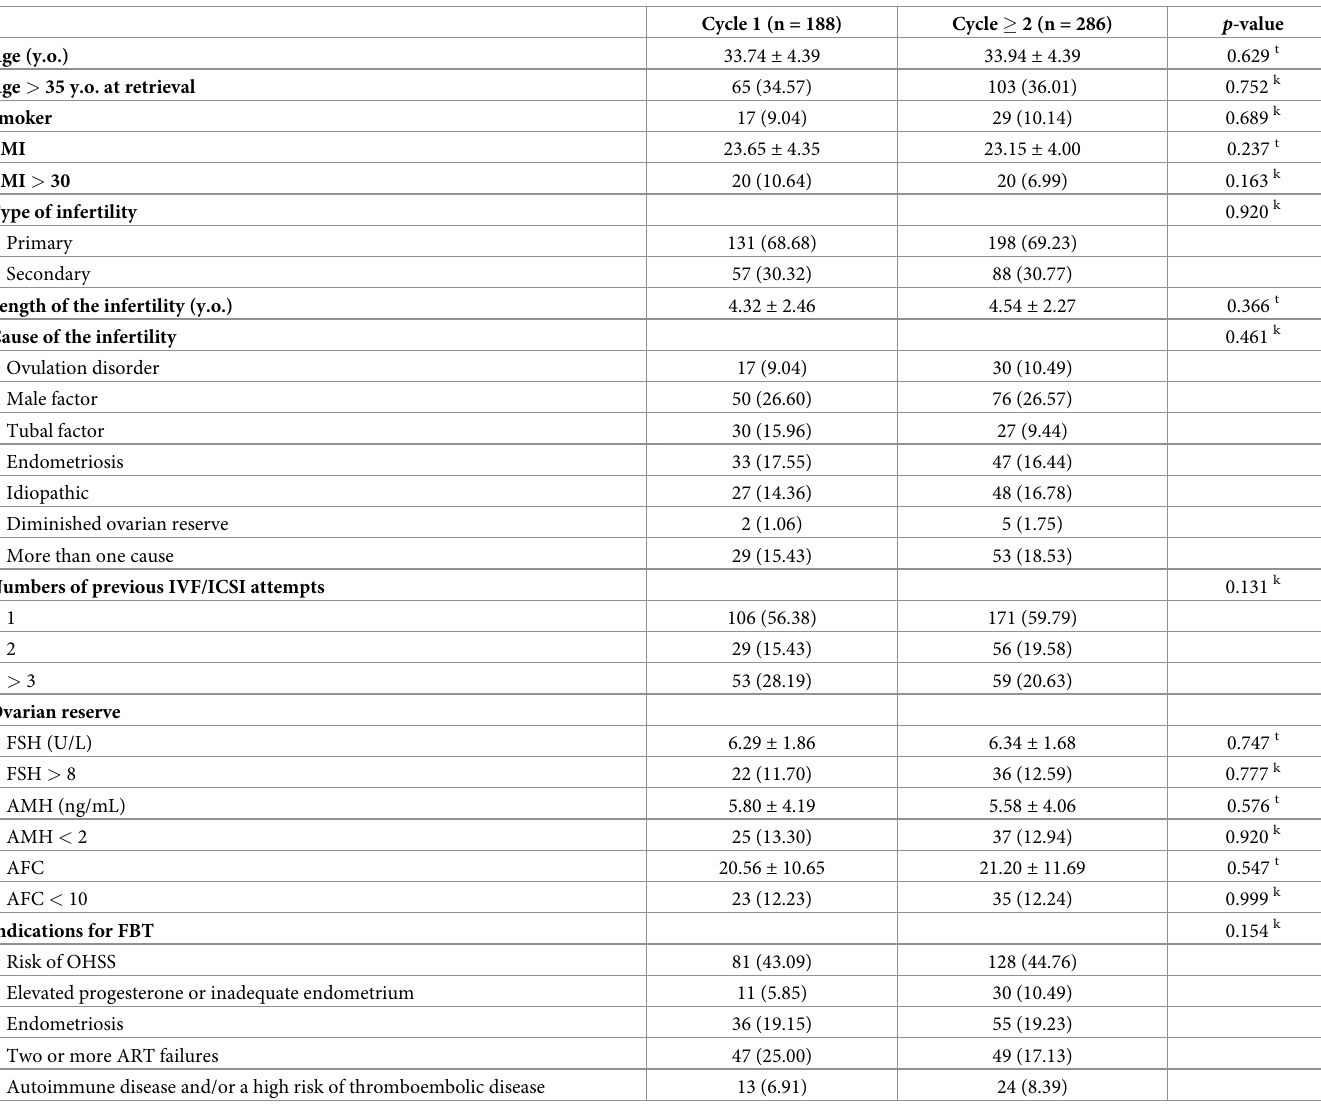
Table 1. Baseline